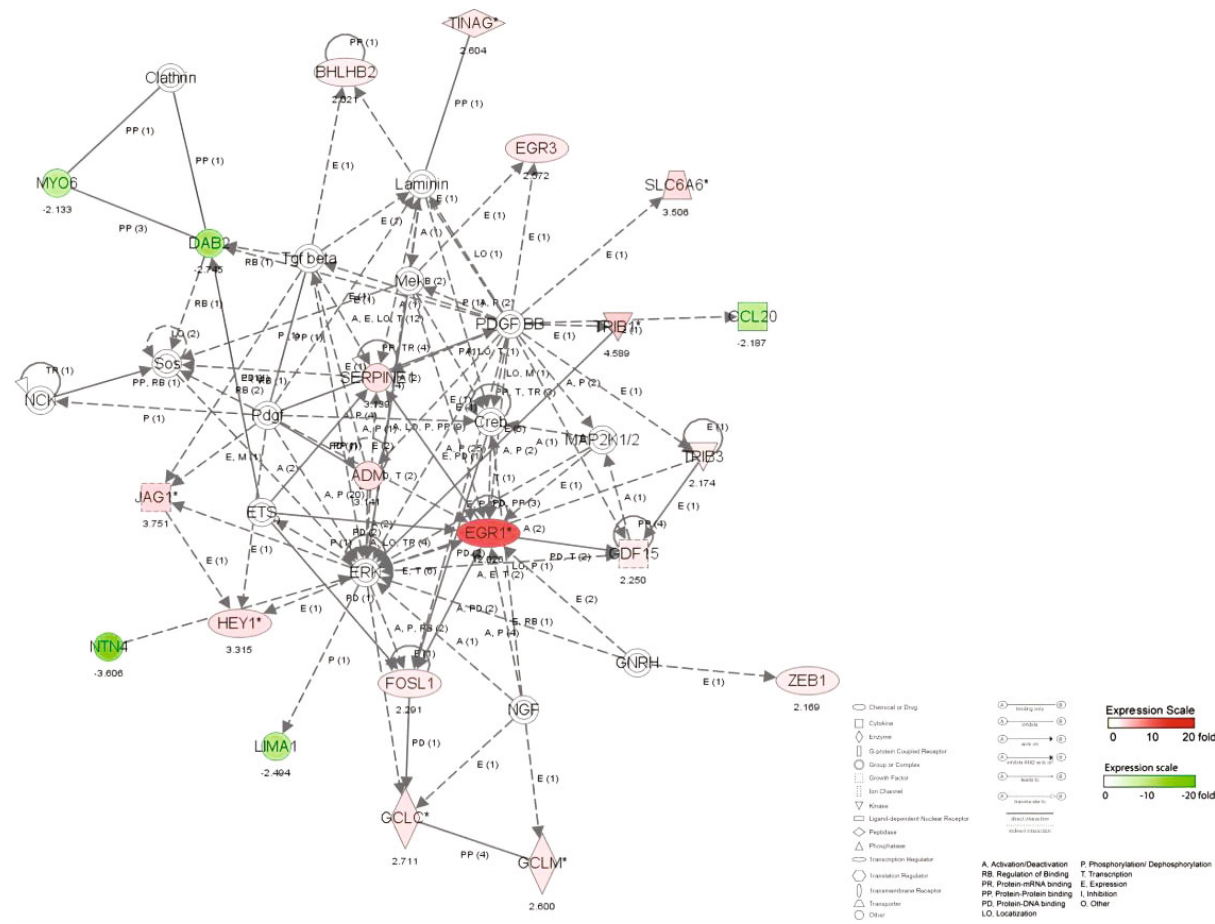
Figure 5: The second most signi fi cant molecular network a ff ected by